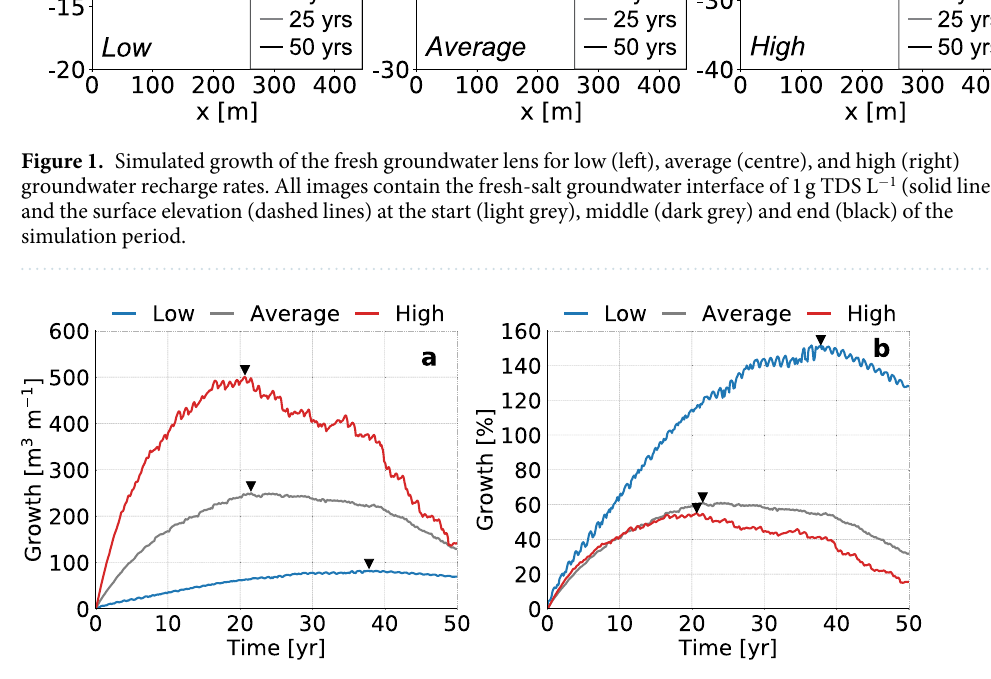
Figure 2. Simulated growth of fresh groundwater for low (blue line), average (dark grey line), and high (red line) estimates of the global groundwater recharge, where the black triangles point to the time with the maximum growth of fresh groundwater. The graphs represent the change in volume (left) and percentage (right) with respect to the initial conditions (i.e. equal to equilibrium state without beach nourishment).